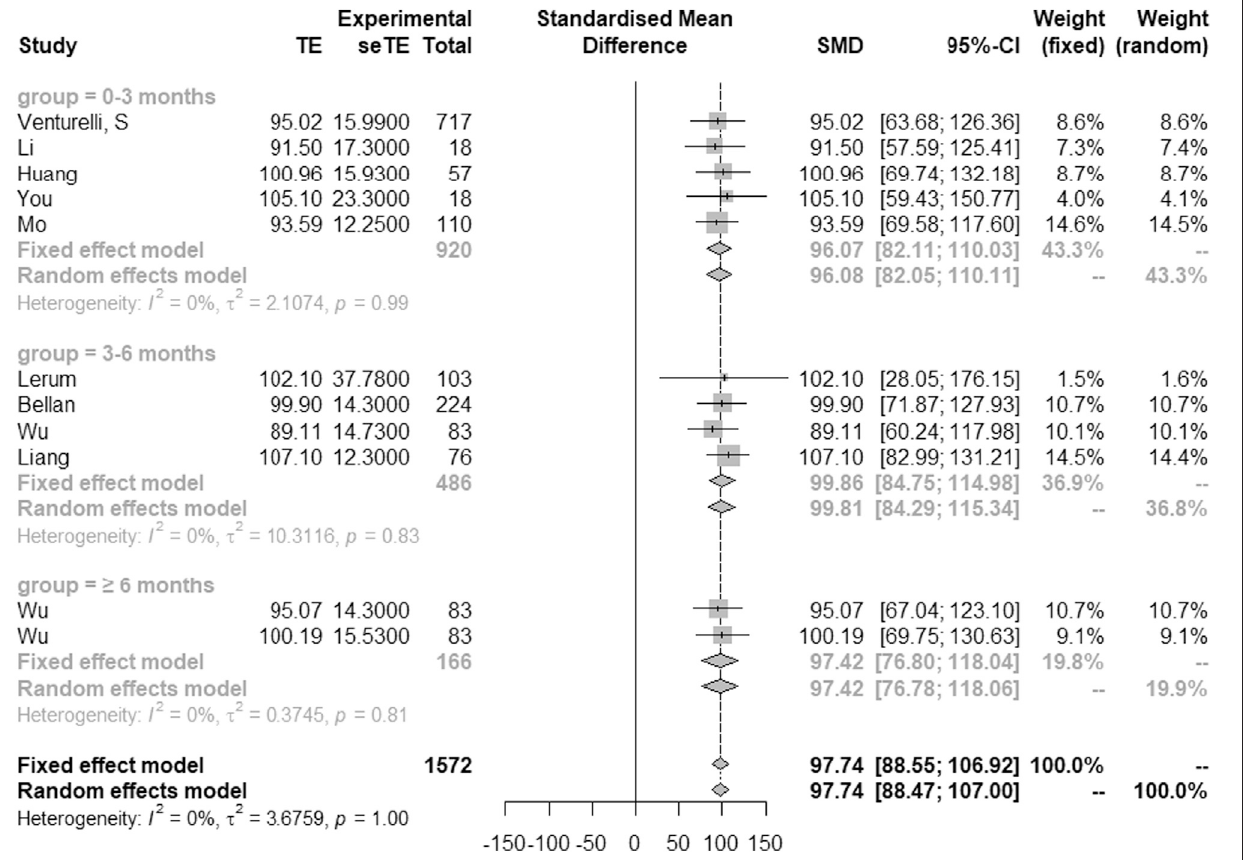
Frontiers in Molecular Biosciences |